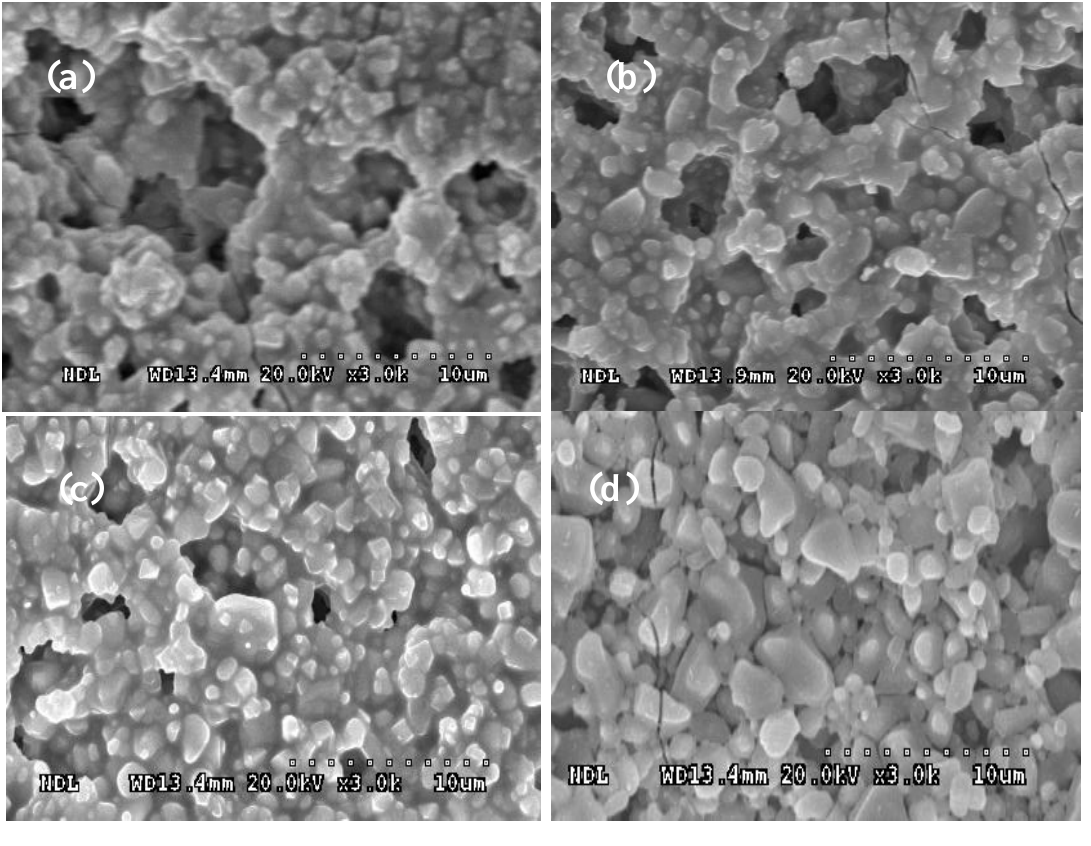
Figure 5. The SPTB layer/p-type Si(100) substrates were fired at 840 °C for 60 min